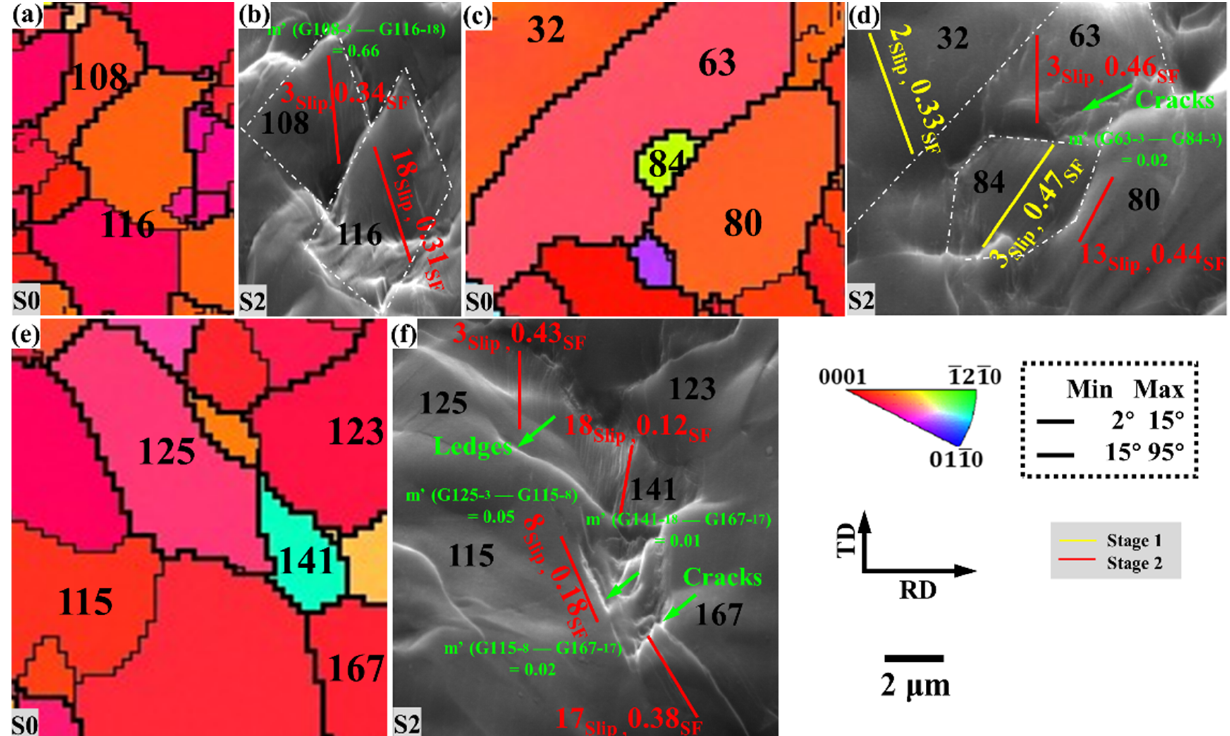
Figure 10. The slip traces of the specimen near the microcrack during uniaxial tension.: ( a , c , e ) IPF images at S0, and ( b , d , f ) SEM images at S2. The slip system represented by the slip traces in the figure is shown in Figure 7.